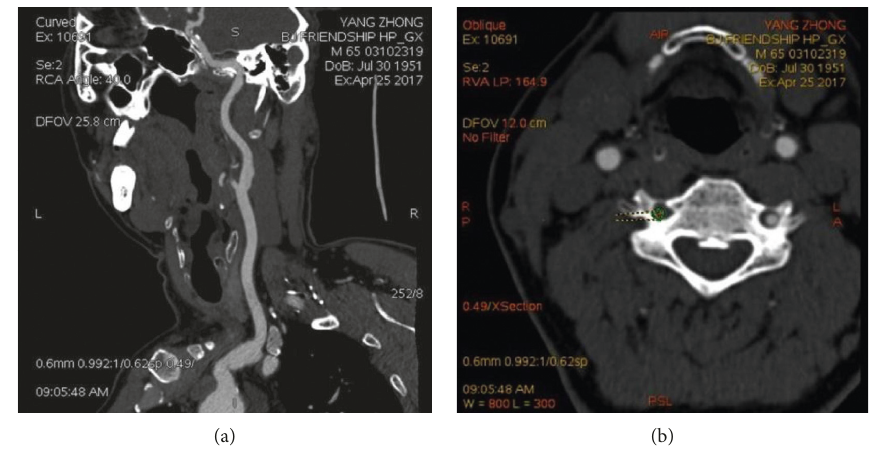
Figure 2: Head-and-neck CTA inspection. (a) Wall calcification of the ICAS; (b) the stenosis of the ICA.